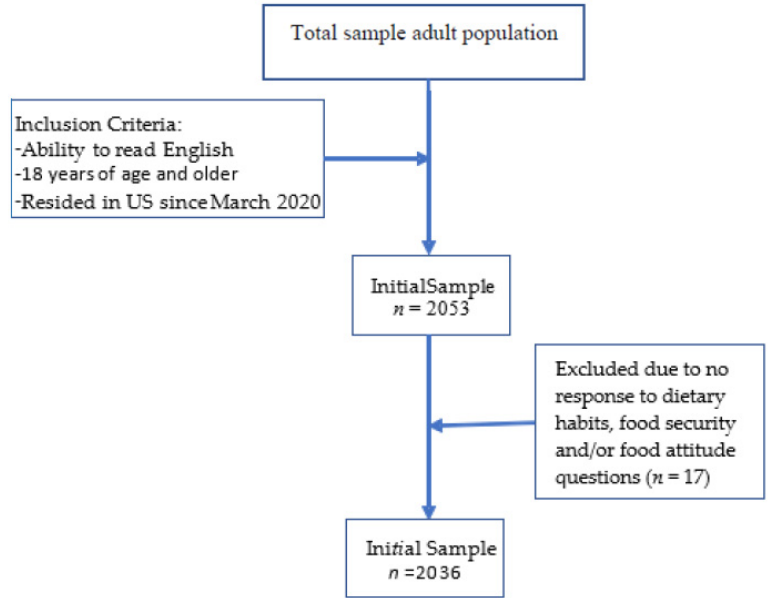
Figure 1. Sample collection chart.